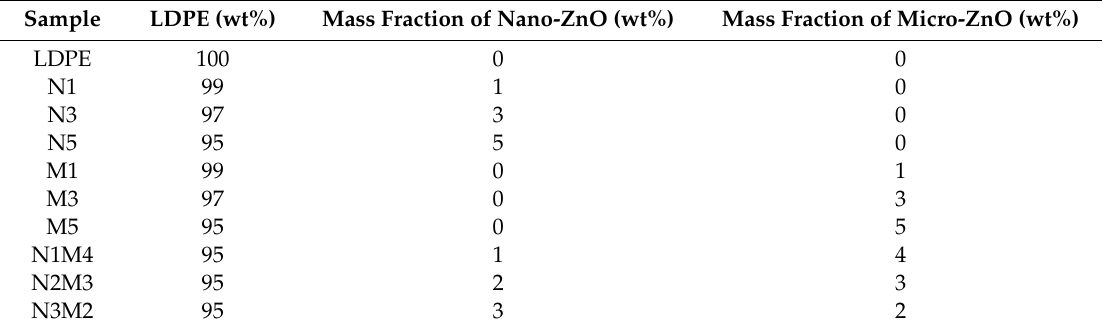
Table 2. The name and filler content of the tested